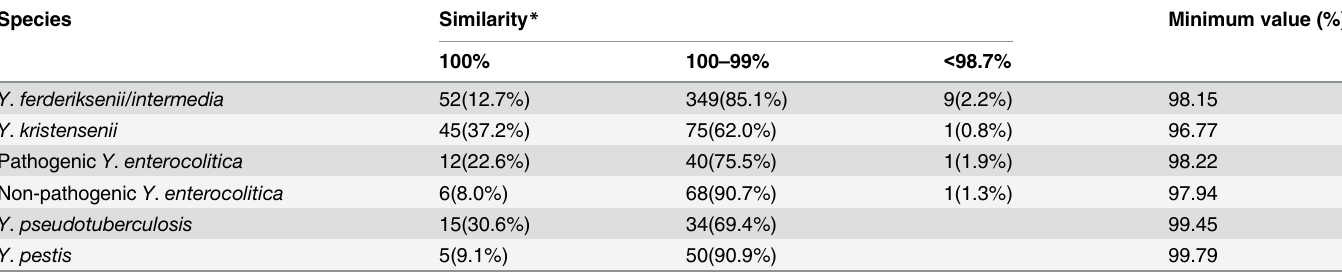
Table 3. Pairwise comparison of 16S rRNA gene at the intra-genomic level in each Yersinia species. Species